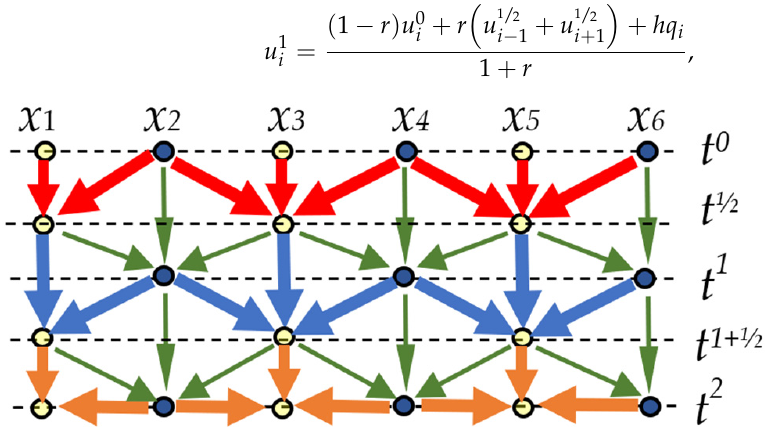
Figure 1. Space–time structure of the leapfrog-hopscotch (LH) scheme. Odd and even nodes are symbolized by light and dark dots, respectively.